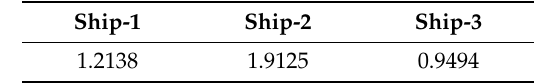
Table 2. The EE for S-RN signals. EE: energy